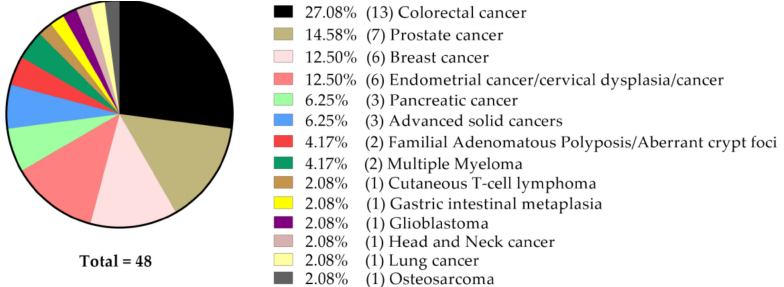
Figure 1. Number and percentage of studies focused on a particular type of cancer, according to its anatomical origin.